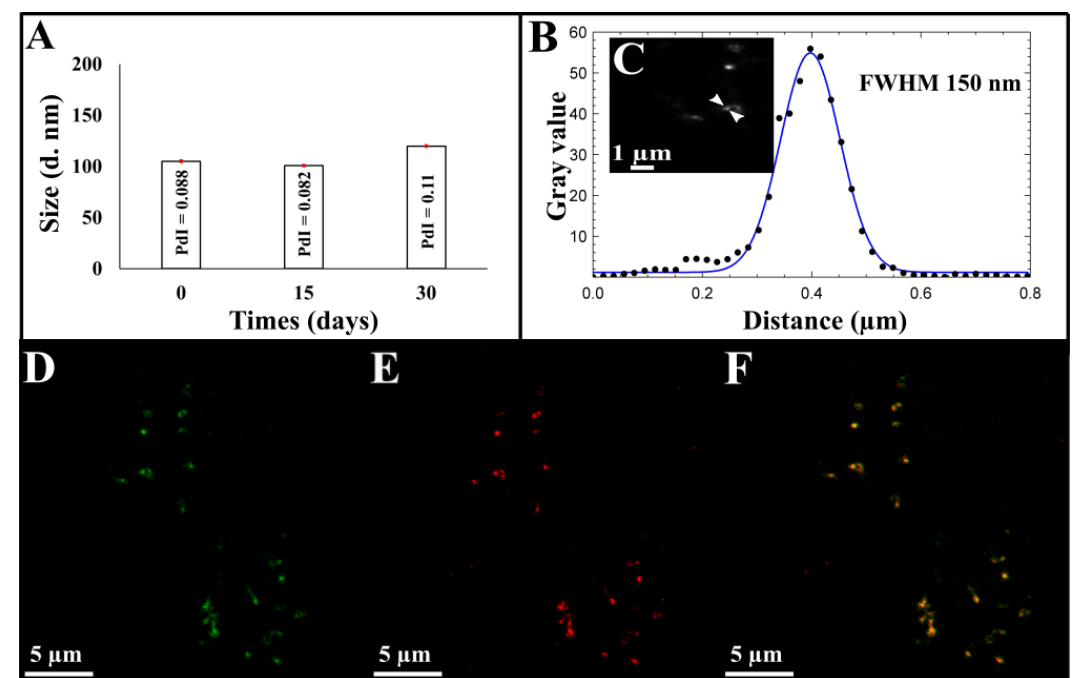
Figure 2. ( A ) Stability of CM-NEsoSomes over time by DLS analysis, ( B ) corresponding line profile of CM-NEsoSome intensities by STED analysis: the black dots depicted in the panel show the intensities of the corresponding pixel values in the image, blue line is the Gaussian fit of the values. Nanocarrier size was extracted from image C, ( C ) STED image of CM-NEsoSome (Scale bar 1 µ m). Confocal images of CM-NEsoSomes ( D ) green channel related to FITC signal of Ct-NEs, ( E ) red channel signal of cell membrane ( F ) overlay (Scale bar 5 µ